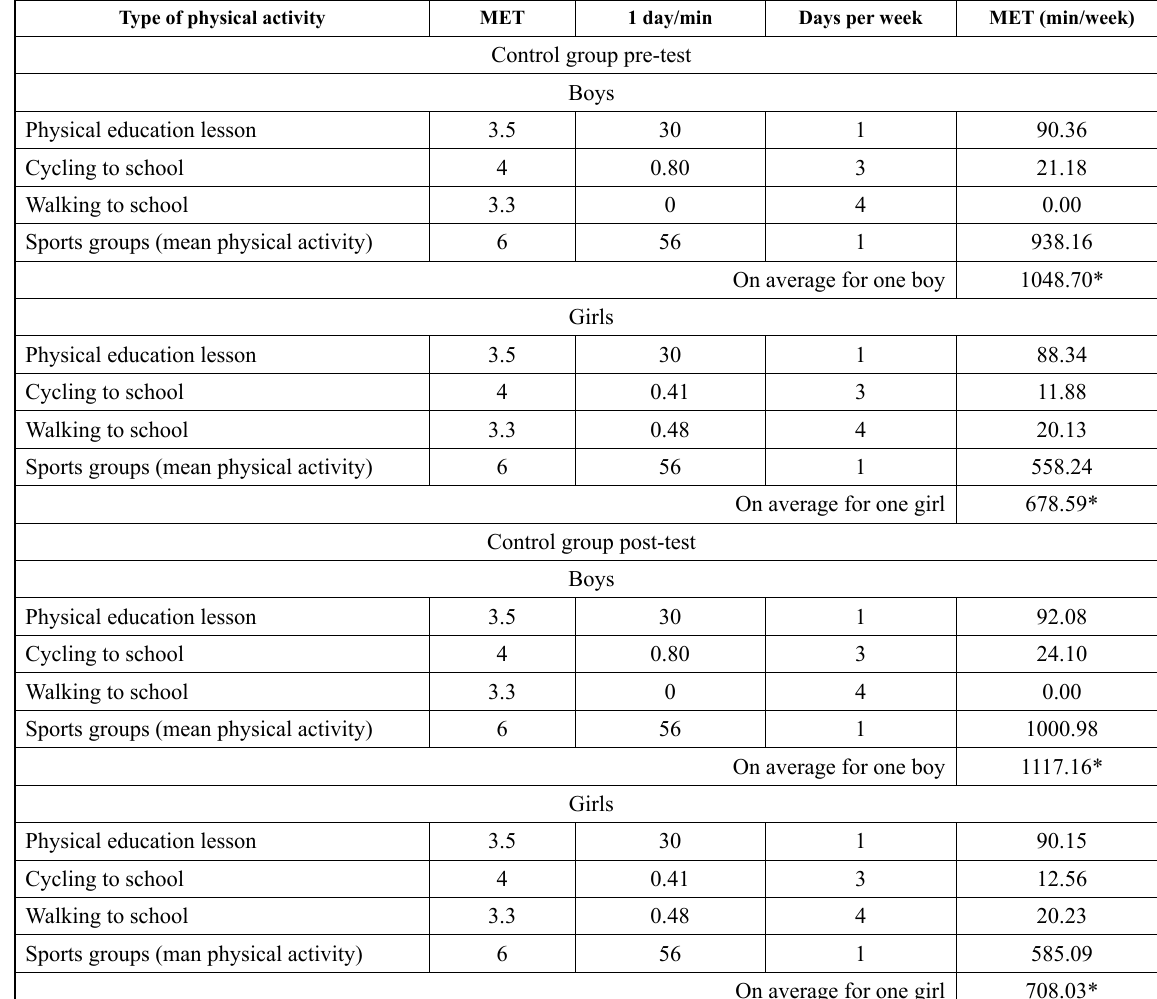
Table 2. Physical activity level using the MET method (the pre-test/post-test results of the control group) Type of physical